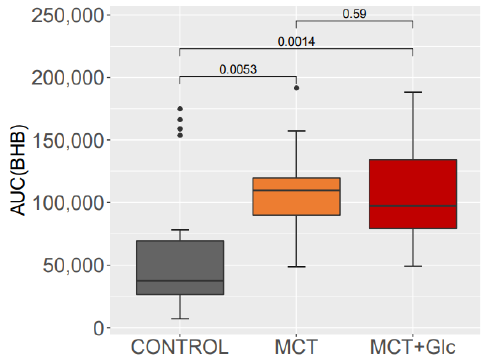
Figure 6. Area-under-the-curve (µg/mL * h/L) for plasma BHB during the five test days (control, MCT, and MCT plus glucose intervention). The area-under-the-curve (AUC) for C8 and C10 is shown in Figure 7. No significant differences between AUC C8 and AUC C10 were observed between MCT oil alone and MCT oil plus glucose intervention during the study day (t0 – t7). Correlations between AUC and metabolic data are presented in the Supplementary Materials, Figure S2.